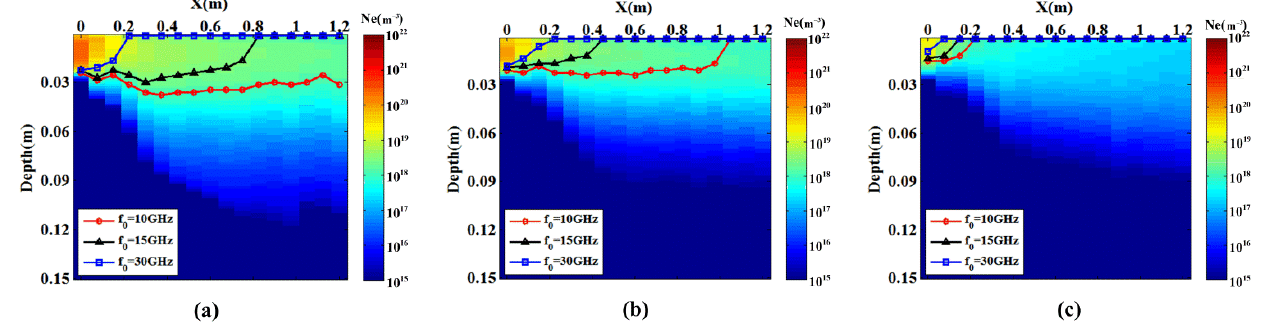
Figure 10. The reflective surface of plasma sheath for scenes 1, 2, and 3. ( a ) Altitude is 30 km. ( b ) Altitude is 40 km. ( c ) Altitude is 50 km.